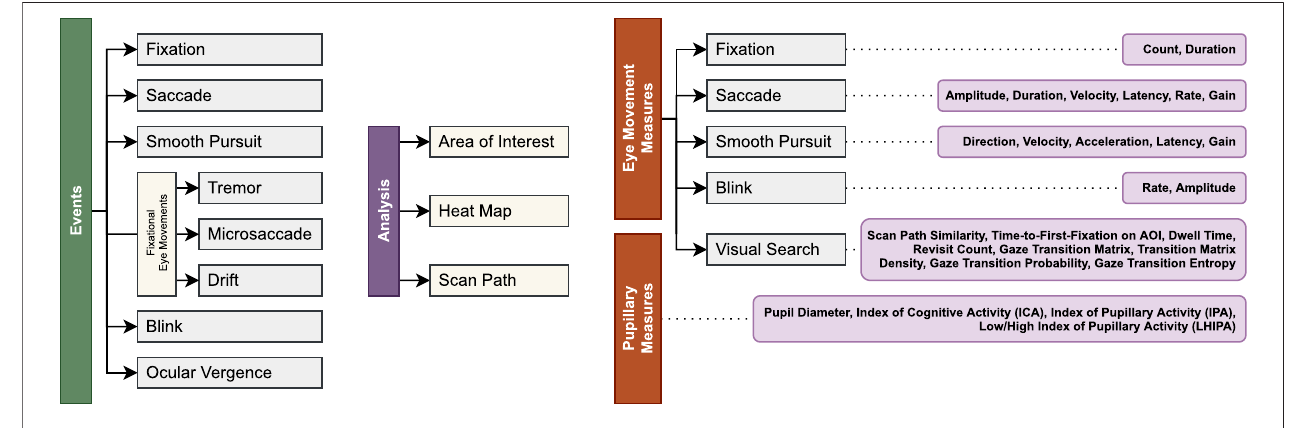
FIGURE 1 | Summary of oculomotor events (left) , analysis methods (center) , and measures (right) .